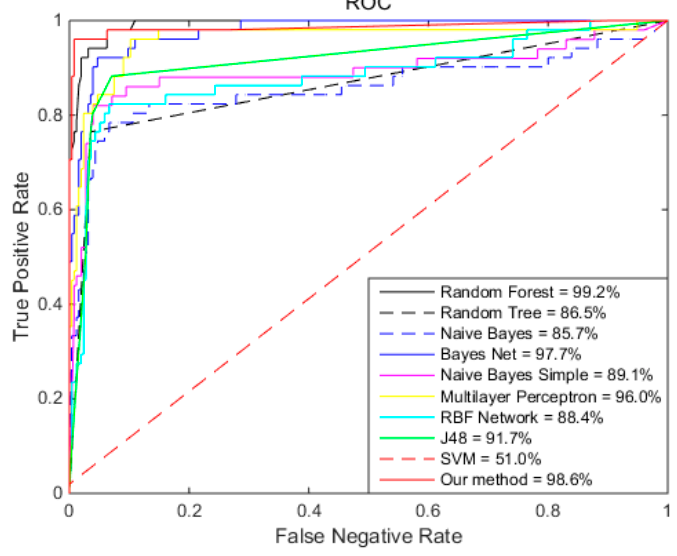
Figure 3. The ROCs of different algorithms on RS features.